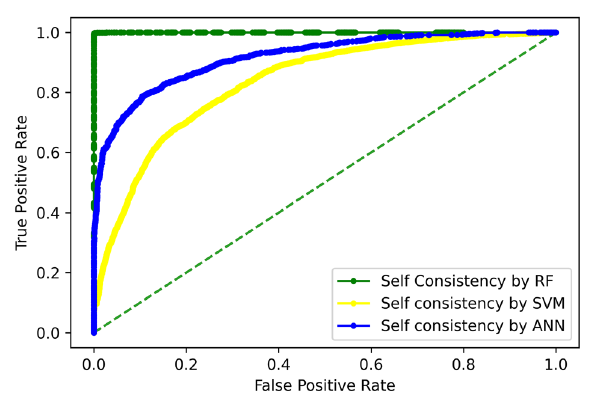
Figure 6. Self-consistency comparison of ROC